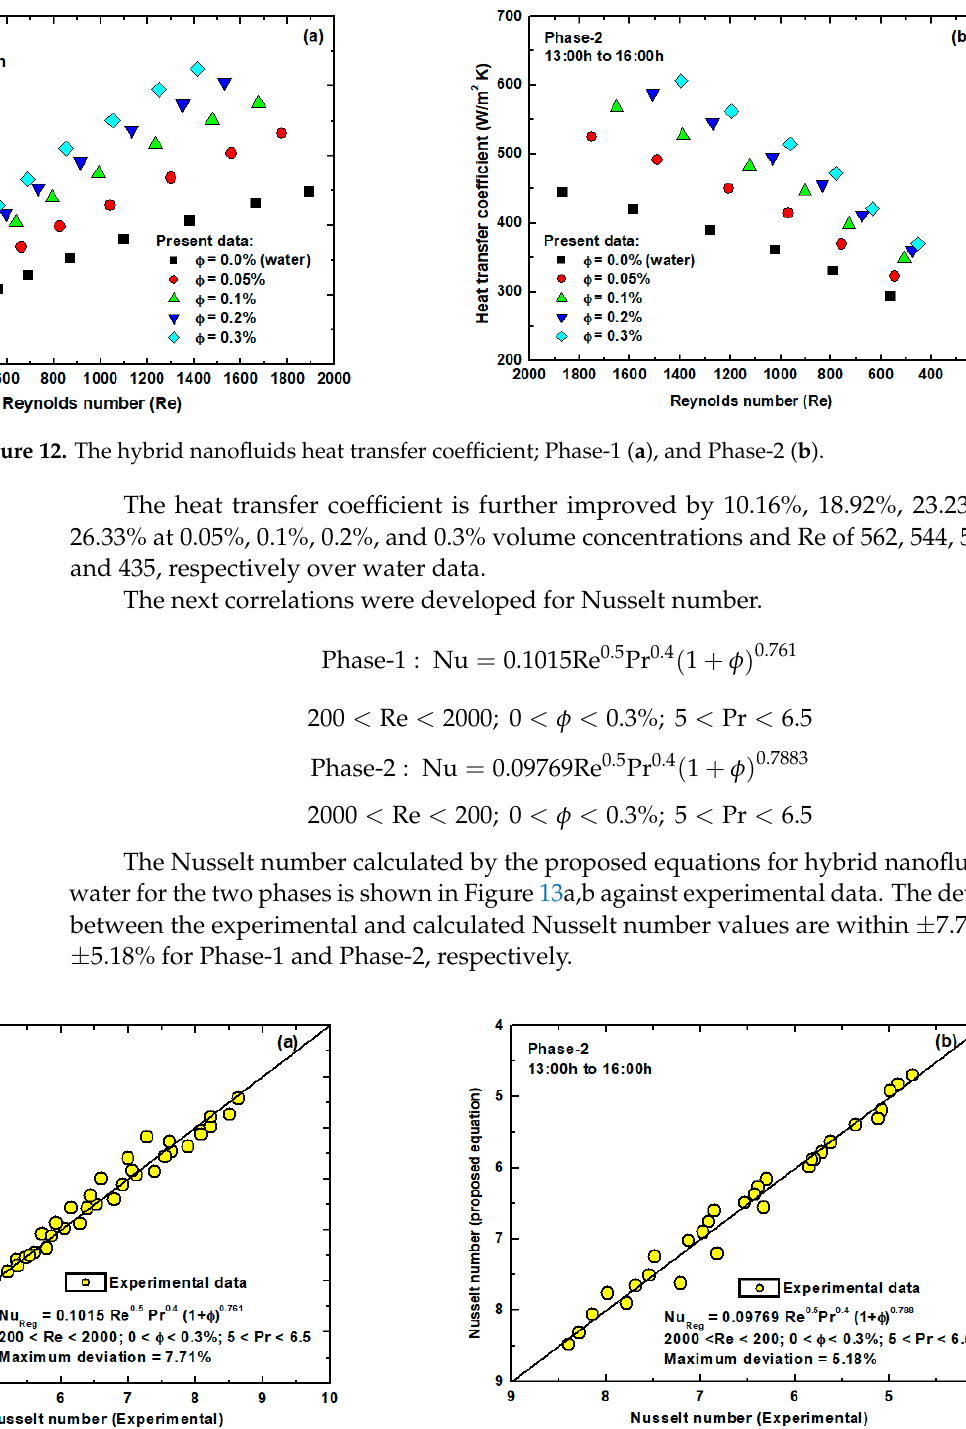
Figure 11. The hybrid nanofluids Nusselt number; Phase-1 ( a ), and Phase-2 ( b ).